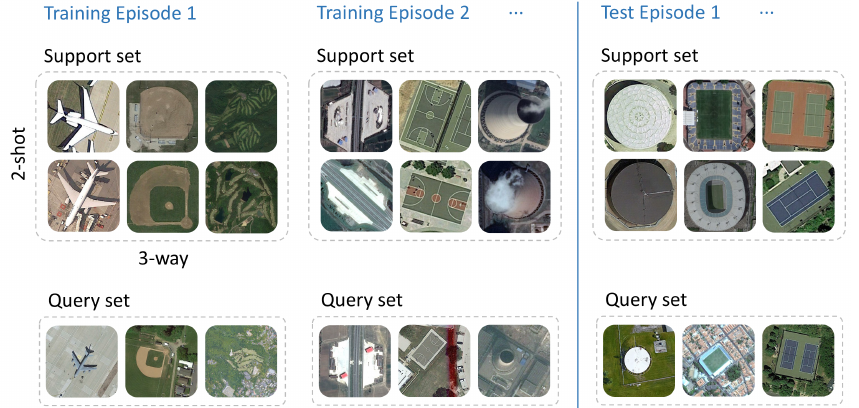
Figure 5. The illustration of 3-way 2-shot episodes in meta